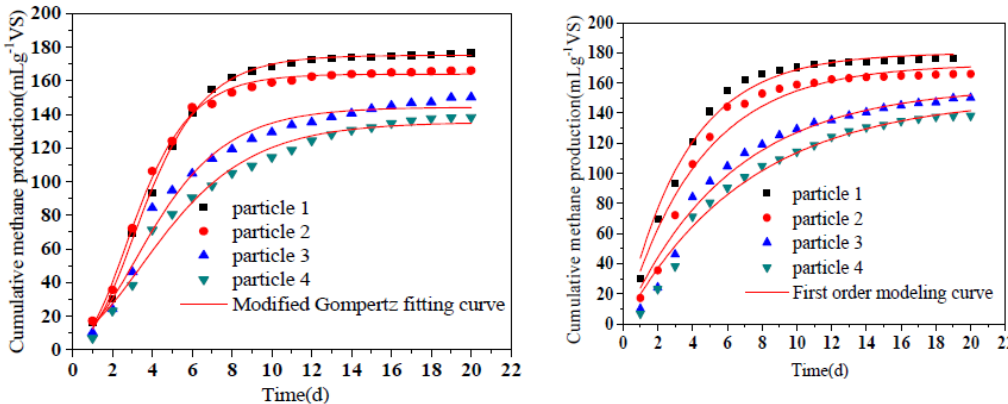
Figure 6. Methane production of different particle sizes in AAD process. Notes: particle 1-4 represent sieve size diameter of 1, 3, 5, 7 mm group, respectively.